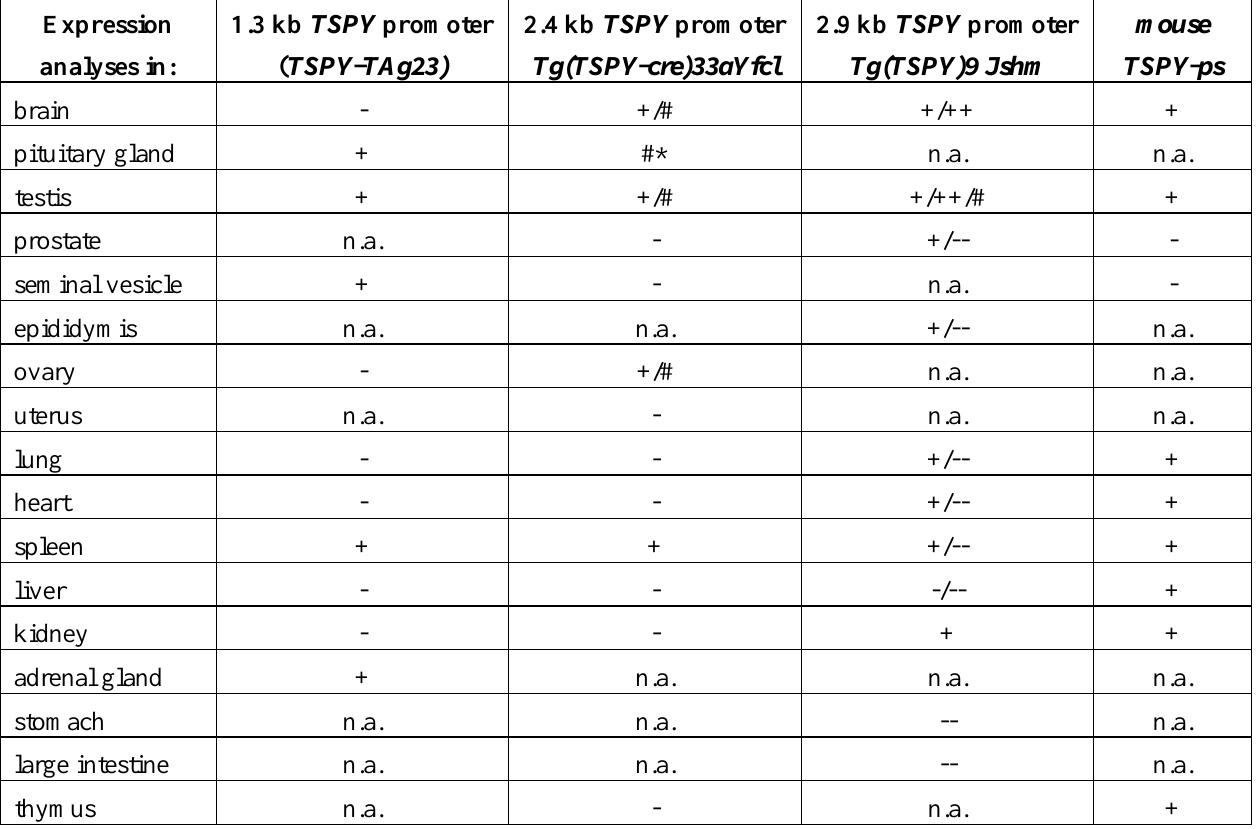
Table 1. Tissue specific expression pattern of mouse TSPY-ps , and the transgenes in the transgenic lines TSPY-TAg23 , Tg(TSPY-cre)33aYfcl and Tg(TSPY)9 Jshm. Expression analyses